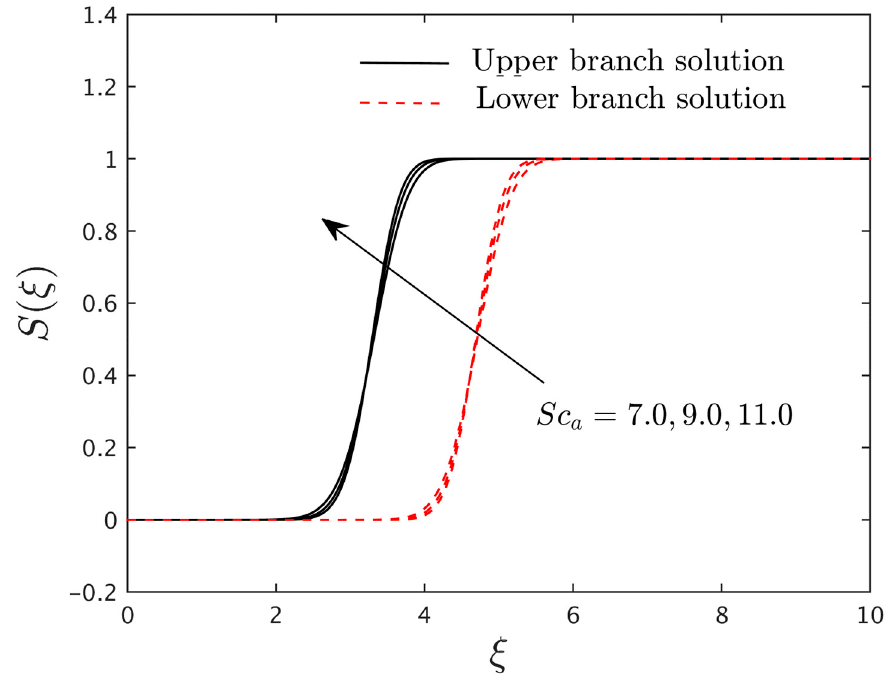
( ) S ξ for the numerous values of